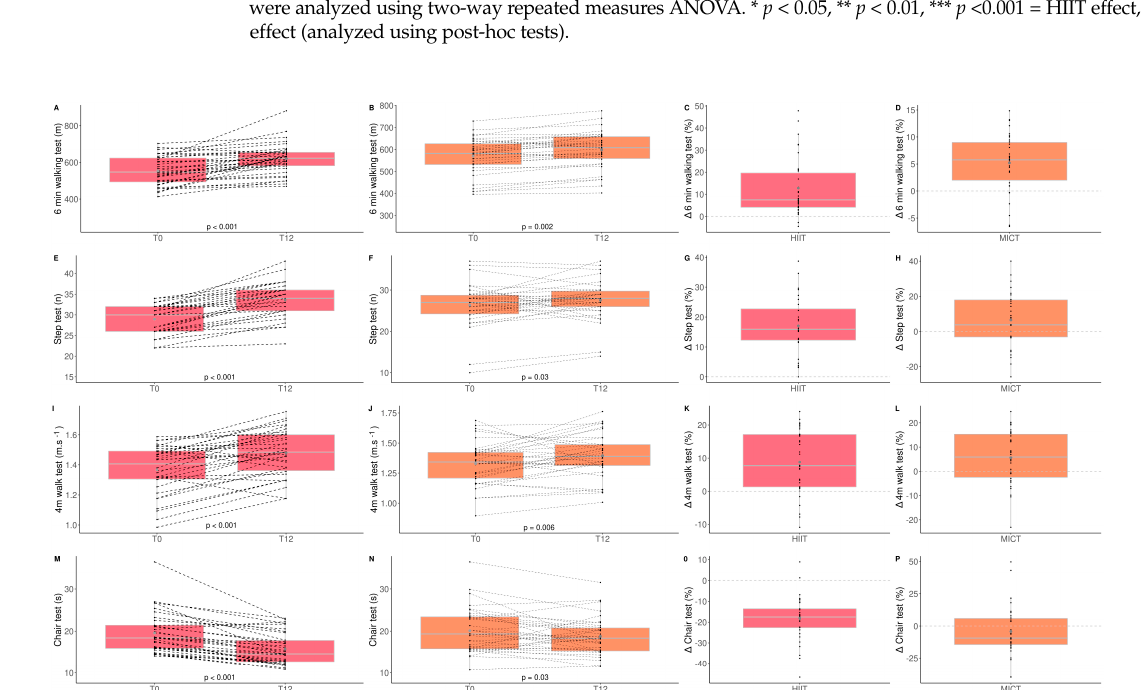
Figure 1. Impact of HIIT and MICT on functional capacities. HIIT = high-intensity interval training (pink), MICT = moderate-intensity continuous training (orange), T0 = before the 12-week intervention, T12 = after the 12-week intervention, delta change between T0 and T12 is expressed in %. six-min walking test for HIIT ( A ), six-minute walking test for MICT ( B ), delta change of six-minute walking test for HIIT ( C ), delta change of six-minute walking test for MICT ( D ), step test for HIIT ( E ), step test for MICT ( F ), delta change of step test for HIIT ( G ), delta change of step test for MICT ( H ), four-meter walk test for HIIT ( I ), four-meter walk test for MICT ( J ), delta change of four-meter walk test for HIIT ( K ), delta change for four-meter walk test for MICT ( L ), chair test for HIIT ( M ), chair test for MICT ( N ), delta change of chair test for HIIT ( O ), delta change of chair test for MICT ( P ). Each black dot represents a subject (the dashed line connects the T0 and T12 values of each subject), the grey point the mean, and the grey line in the boxplot the